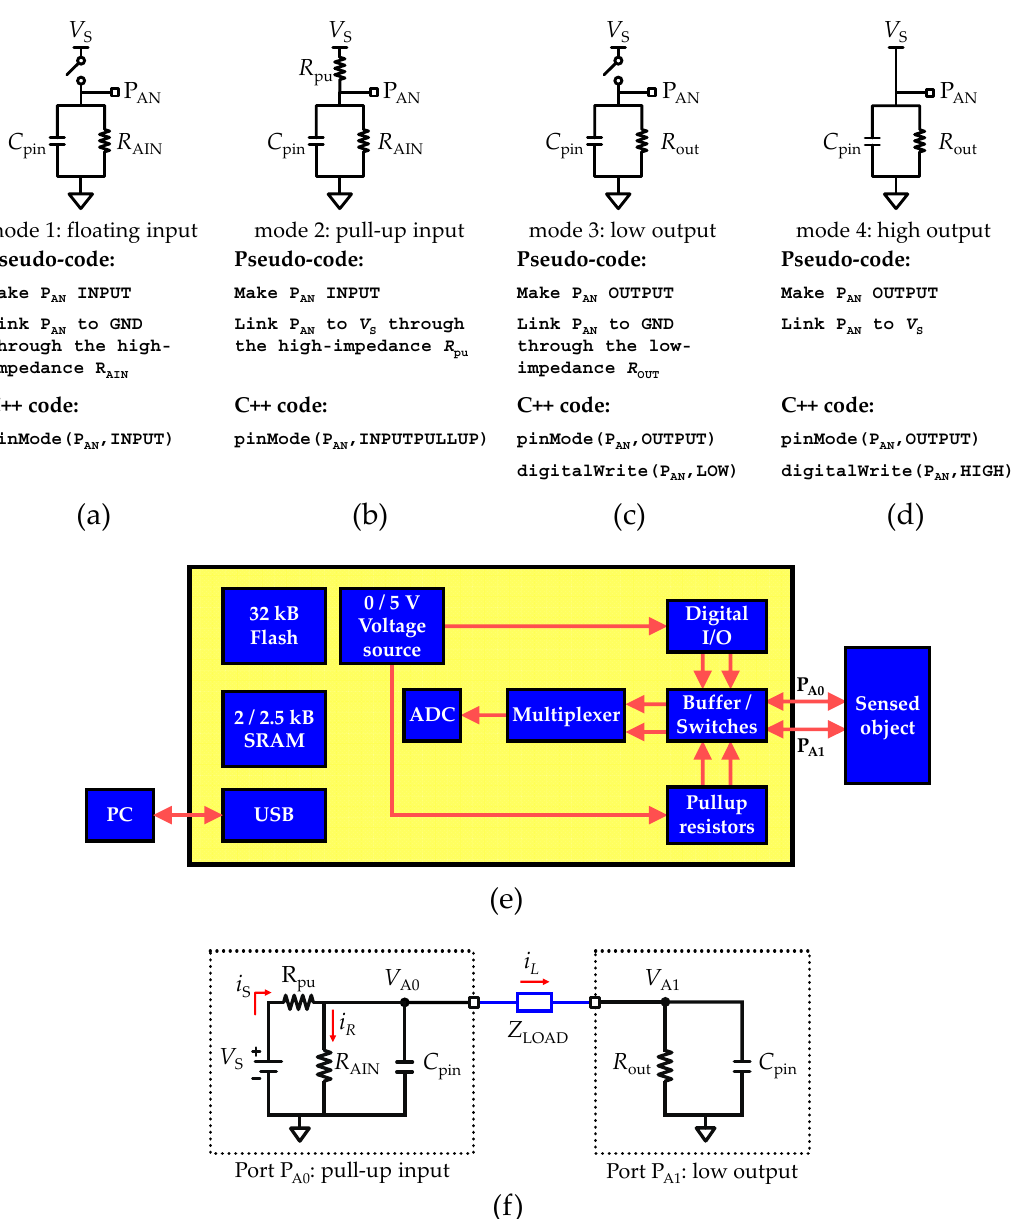
Figure 1. Equivalent circuits for the four operation modes available to configure each analog in- put/output (I/O) port. ( a ) mode 1, floating input. ( b ) mode 2, pull-up input. ( c ) mode 3, low output. ( d ) mode 4, high output. Each equivalent circuit is adapted from the schematics provided in the datasheets. ( e ) Block diagram of the proposed measurement system, including the serial communi- cation and voltage source through USB interface to local PC, flash and SRAM memory, internal voltage source, and internal circuitry to program I/O ports to digital or alternate functionalities. ( f ) Equivalent circuit of two analog I/O ports bridged with a load impedance (Z LOAD ).